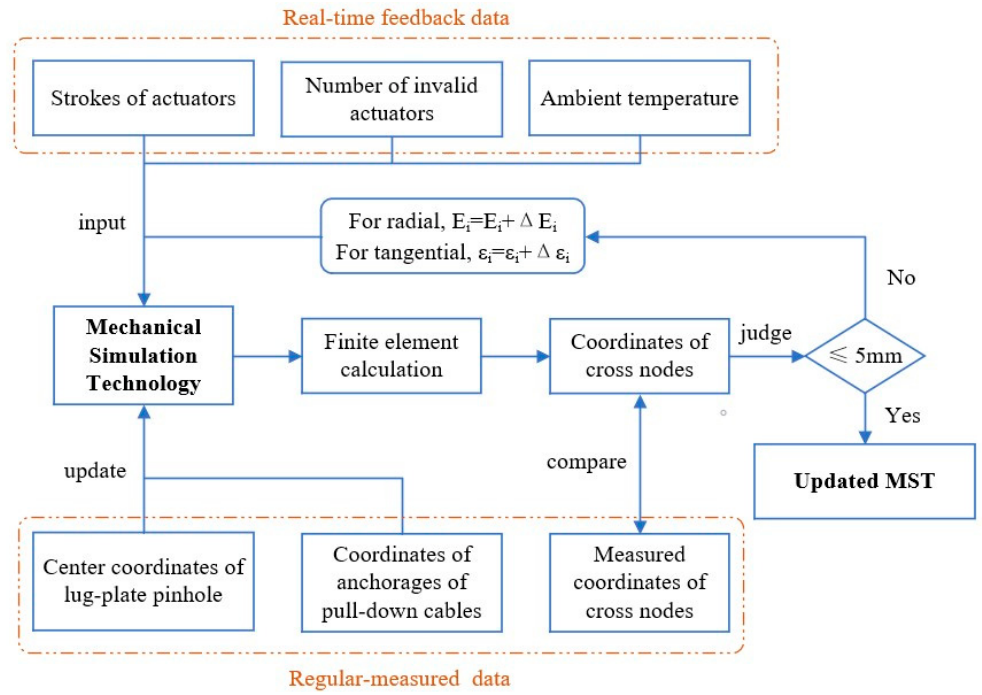
Figure 5. Flow chart of the updating process.